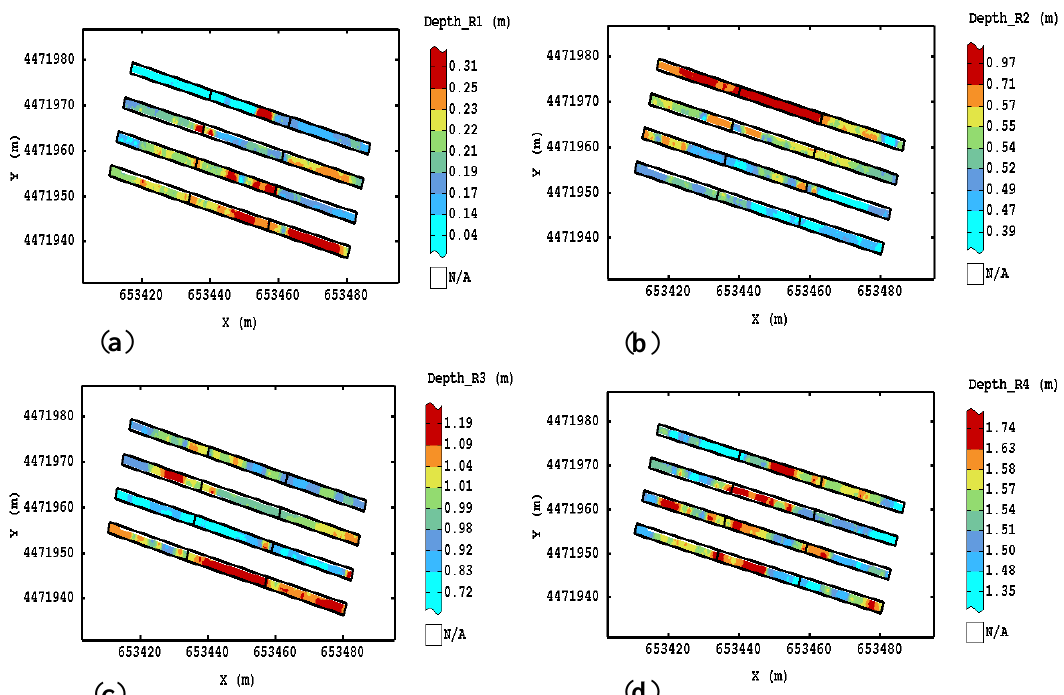
Figure 7. The cokriged maps for depths of soil discontinuities: ( a,b ) represent the depths involved directly in the sampling; ( c ) is the layer not directly involved in the sampling; ( d ) represents the depth of the fourth reflection (R4, between 1.35 and 1.74 m), which corresponded to the effective depth range of ECa obtained in vertical polarizations. Color scale uses iso-frequency classes.